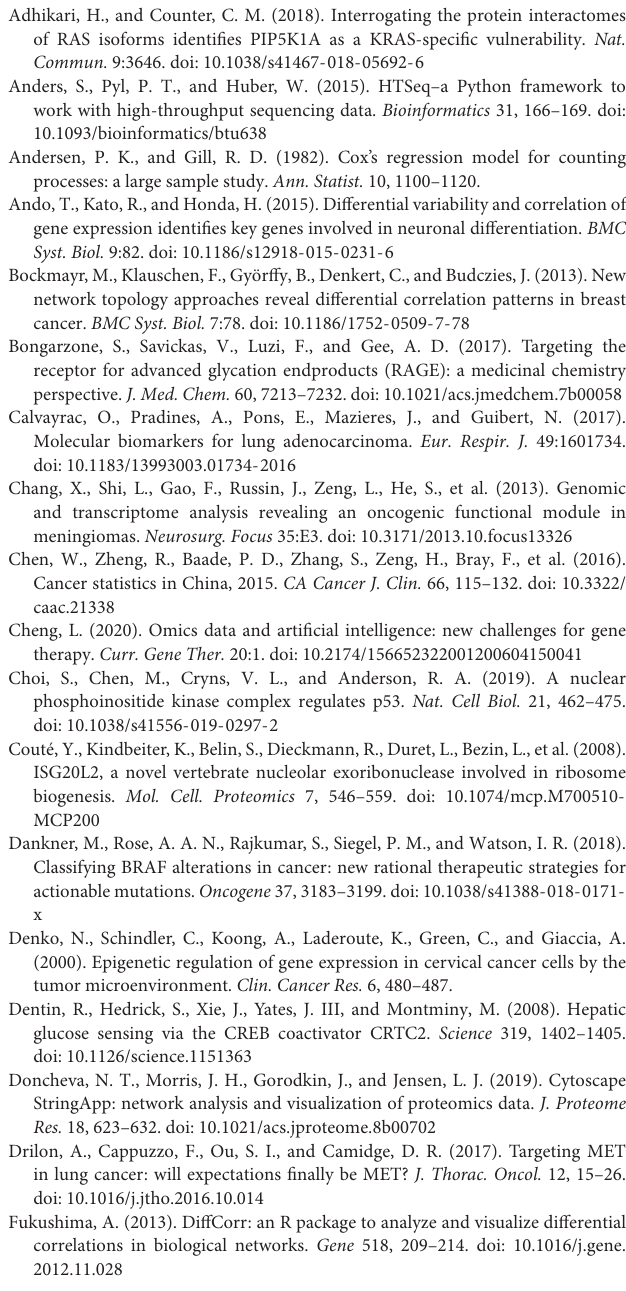
Supplementary Table 3 | The members of each module. Supplementary Table 4 | Pair-wise differential correlations in the yellow module. Supplementary Table 5 | Pair-wise differential correlations in the mediumorchid